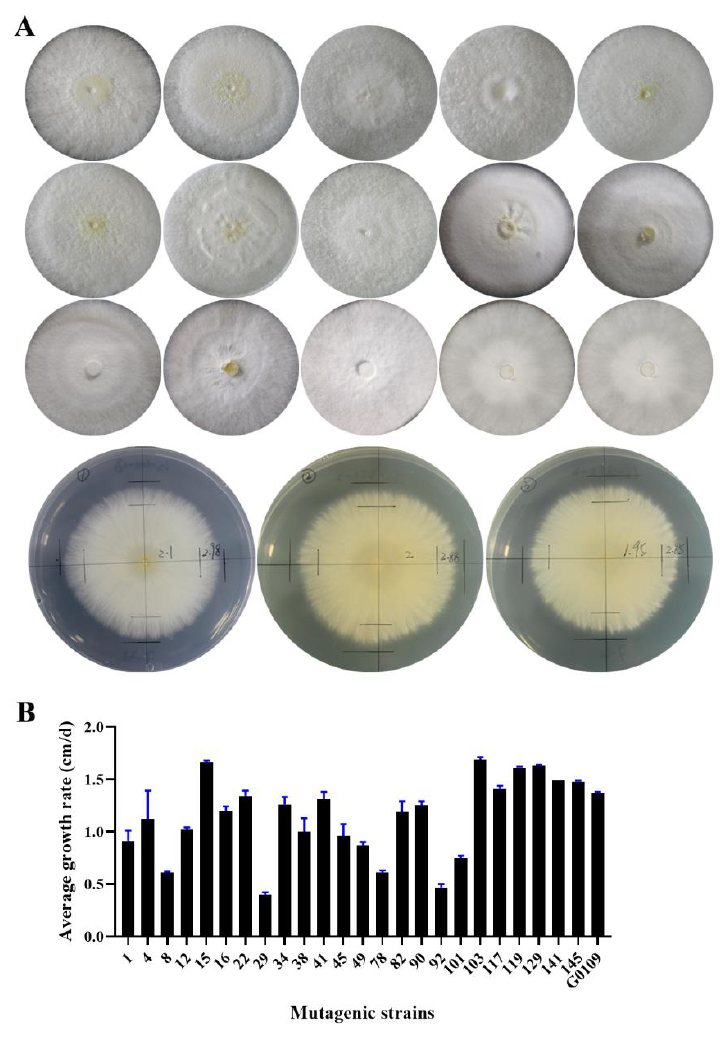
Figure 2. Mycelia growth characteristics of mutagenic strains. ( A ): Mycelia morphology and growth rate of some mutagenic strains; ( B ): Mycelia growth rate of some mutagenic strains. Table 1. Mycelia characters of some mutagenic strains.